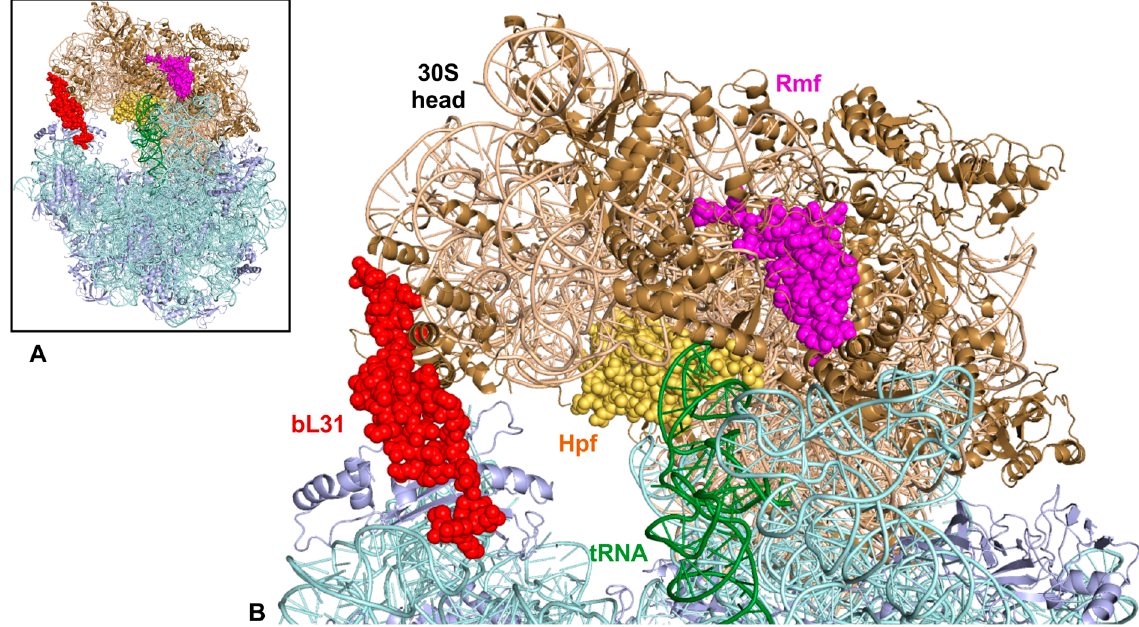
Figure 4. Structure of Rmf and Hpf bound to 70S ribosome. ( A ) Overall view of the complex. Rmf (magenta), Hpf (yellow), and bL31 (red) are shown as spheres. rRNA and proteins of the ribosome subunits are shown as cartoons in either teal and light blue (50S) or wheat and sand (30S) colors, respectively. tRNA bound to ribosome A-site is shown as cartoon and colored green. ( B ) detailed view of 50S and 30S interface between 50S central perturbance and 30S head region. The model for the Rmf–Hpf–70S was obtained from a published cryo-electron microscopy structure of the E. coli 70S particle in complex with Rmf, Hpf, and an A-site tRNA (PDB ID: 6H4N) [27] .